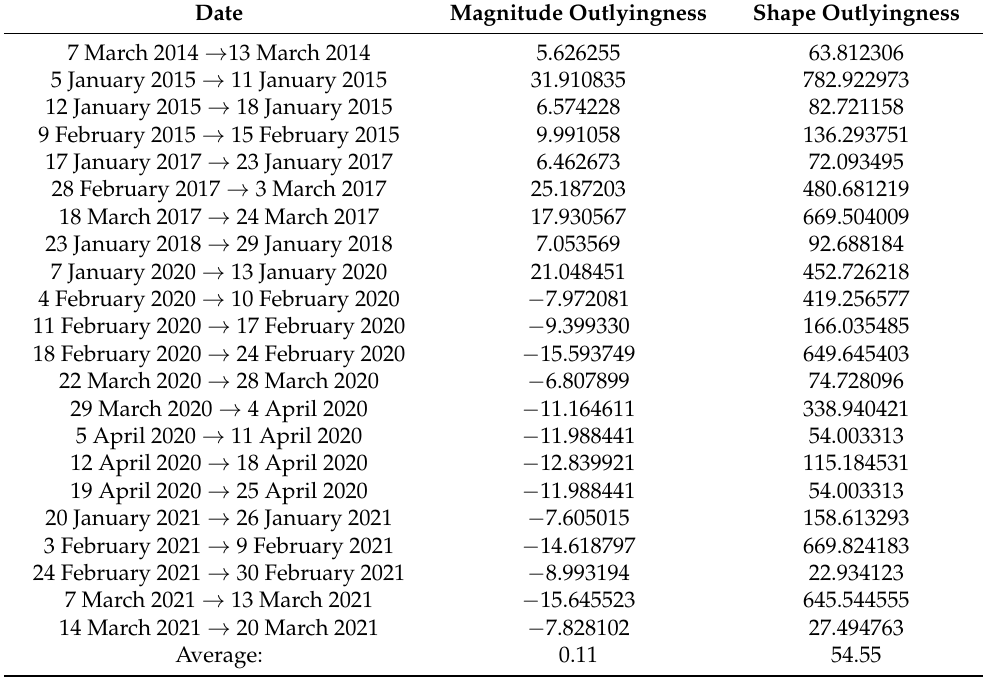
Table 2. Weekly SO 2 outliers of the improved method with the modified band depth. The first column includes those outlying weeks of the first quarter of every year, defined by their first and last day. The second column presents the magnitude outlyingness of those functions, which quantifies how much a function is shifted compared to the rest. The last column shows the shape outlyingness, a parameter that expresses to what degree a function has a different structure than the